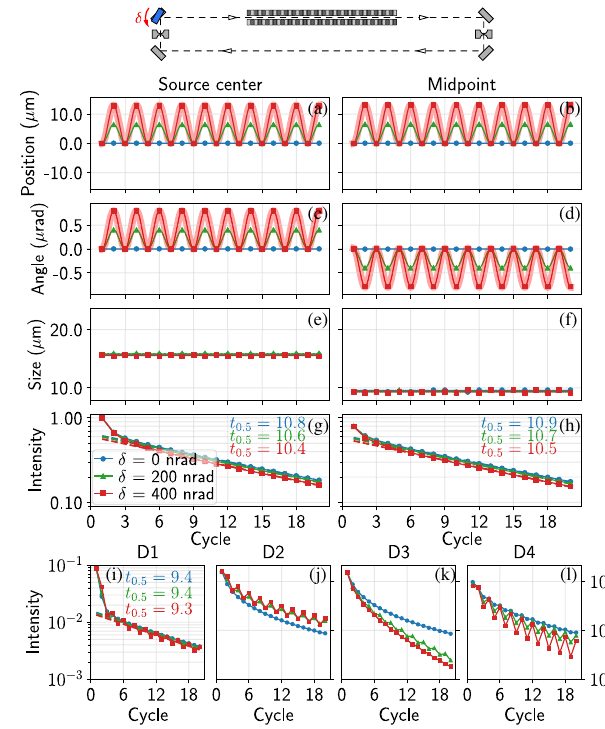
FIG. 22. Similar to Fig. 21, but with yaw angle error δ at crystal C 4 .